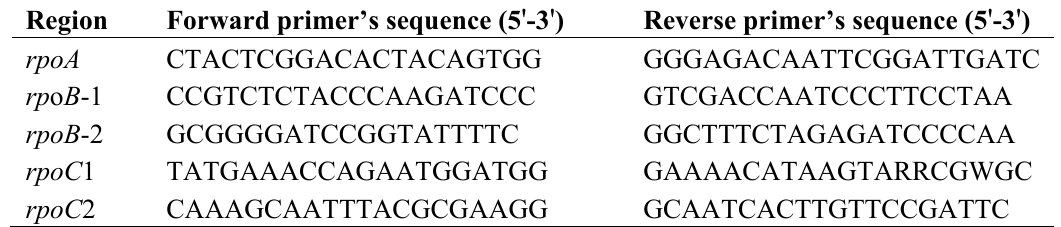
Table 3. Sequences of DNA primers used in the present